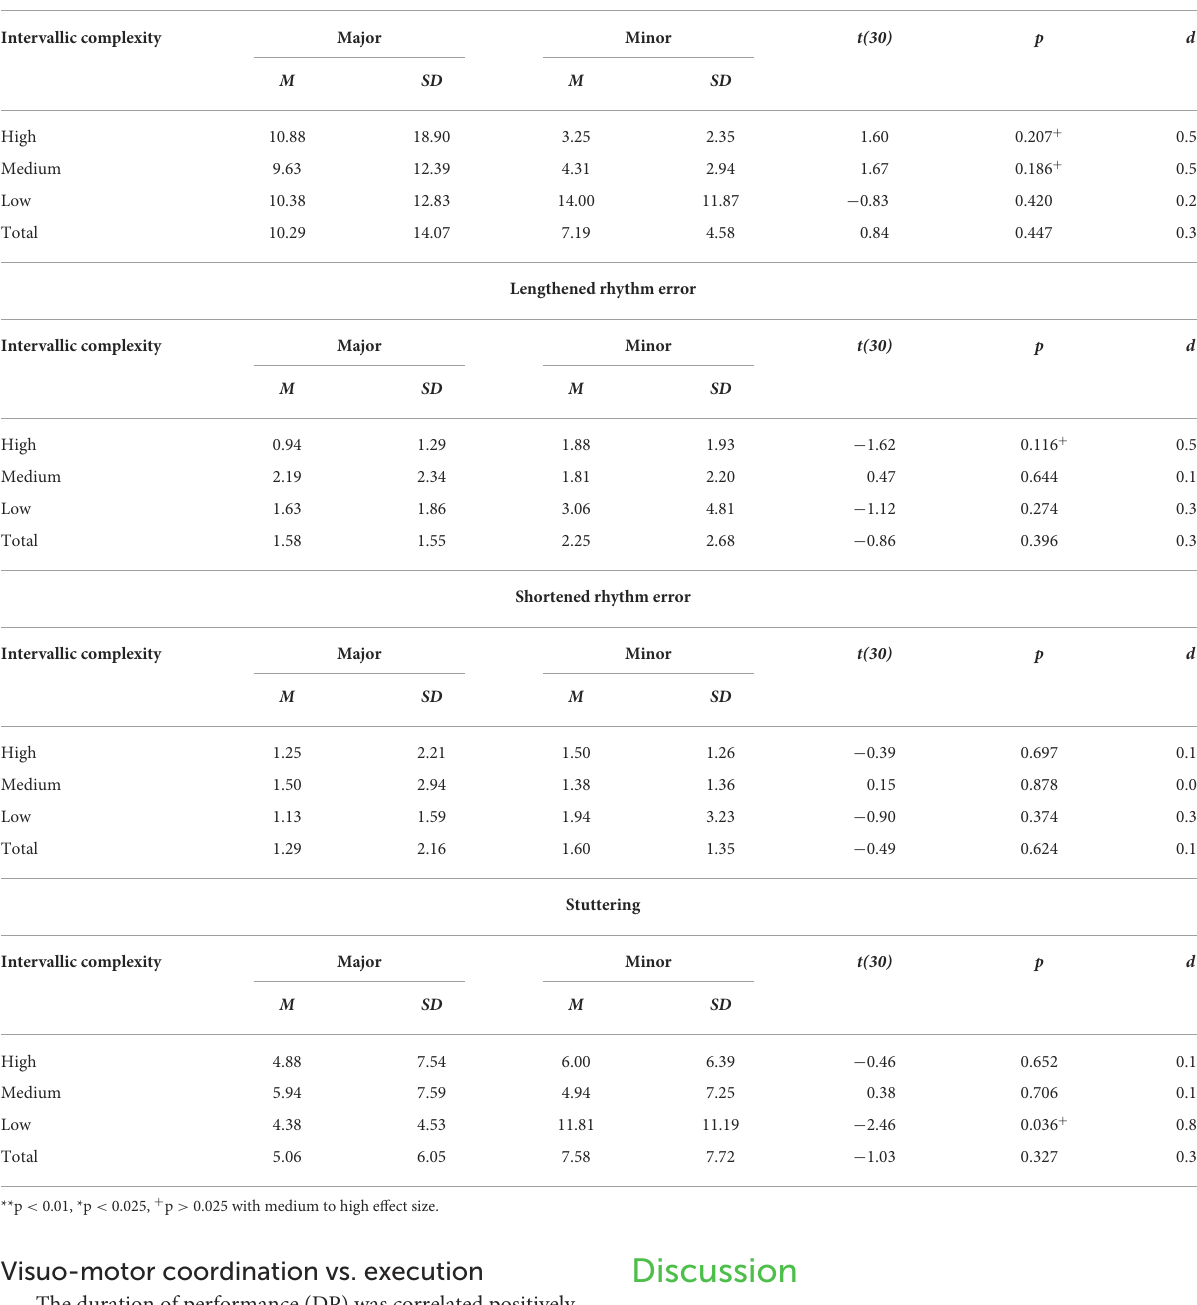
TABLE 4 Means and standard deviations of four dependent variables for an accuracy of execution, as well as results of bootstrap t -tests with Bonferroni’s correction ( subset α = 0.025) for effects of modality on each measure. Pitch